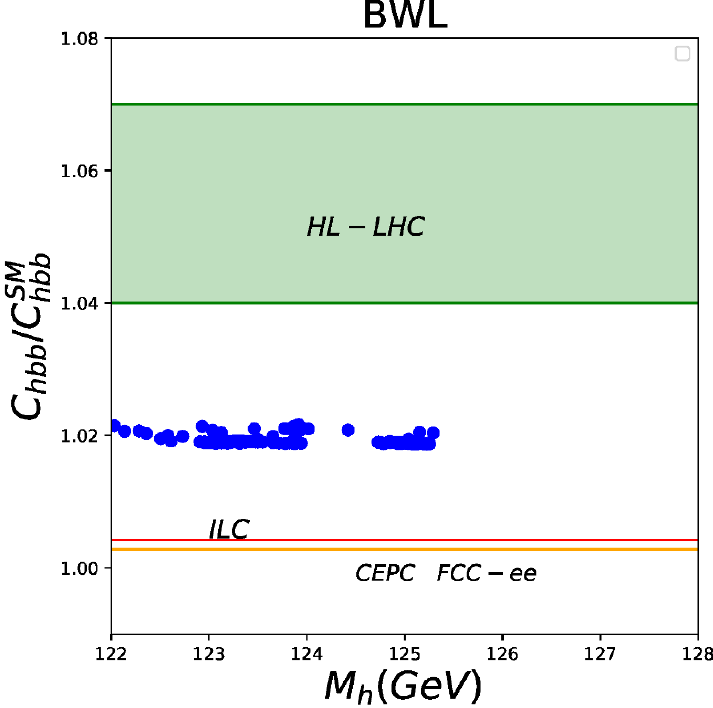
Figure 7 . The reduced SM-like Higgs coupling C Z < 2 (cid:27) for the BWL scenario in (cid:12)gure 6. The sensitivities of the HL-LHC (14 TeV, 3 ab (cid:0) 1 ) [73], ILC (250 GeV, 2 ab (cid:0) 1 ) [74], FCC-ee (240 GeV, 5 ab (cid:0) 1 ) [75] and CEPC (240 GeV, 5 ab (cid:0) 1 ) [76] to the Higgs couplings are also